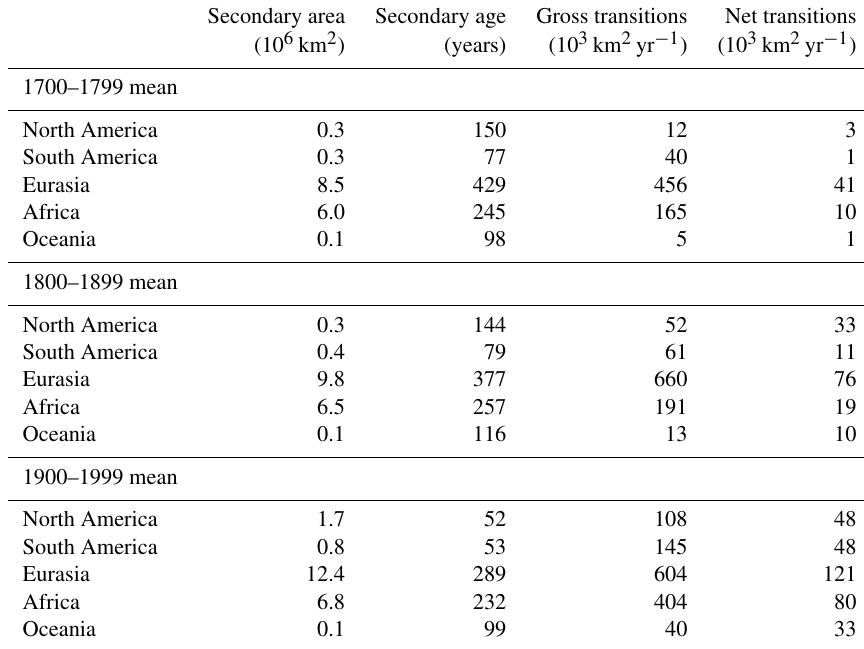
Table 6. Regional results for 1700–2000 (historical